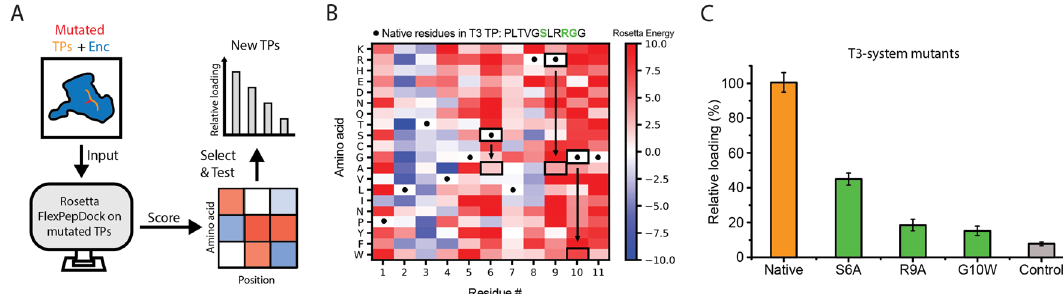
Figure 5. Design and characterization of novel targeting peptide mutants. ( A ) Workflow outlining the design and testing of mutant targeting peptides. ( B ) Heat map of computationally generated point mutations within the M. xanthus T3 targeting peptide. The color gradient represents the Rosetta Energy score (blue: improved binding, red: worse binding). Native sequence residues are indicated by asterisks. The mutants selected for experimental testing are shown with black arrows pointing from the native residues (asterisk) to the mutant residues. ( C ) Bulk fluorescence measurements of mutant targeting peptides. Error bars represent standard deviations resulting from three independent replicates. Fluorescence measurements of the native and control TP for the T3 system are shown for